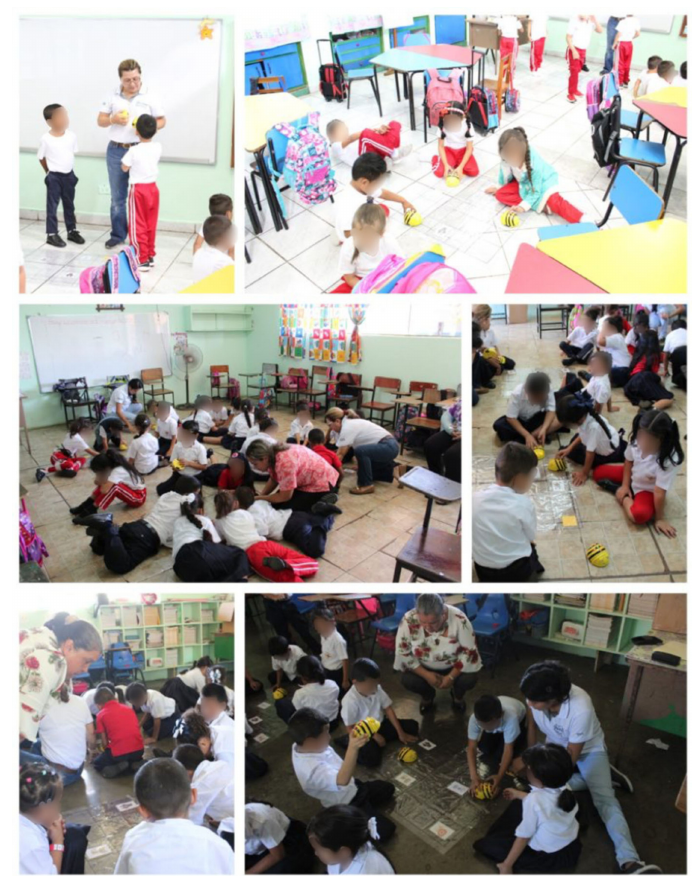
Figure 3. Practical workshop on the use of Bee-Bot with